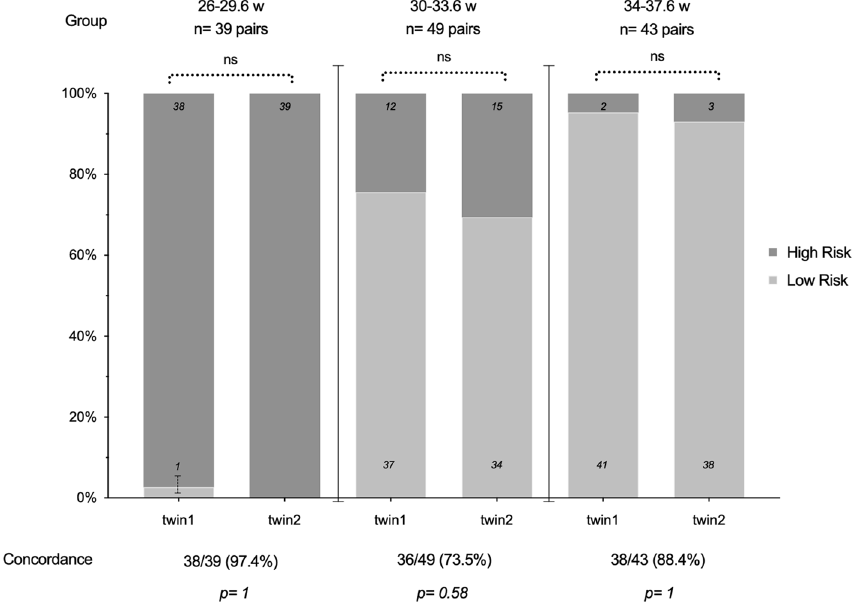
Figure 2. Comparison of QuantusFLM results between twins according to groups of gestational age. Data presented as frequencies or percentage (%). *p value is determined with the McNemar test of paired nominal